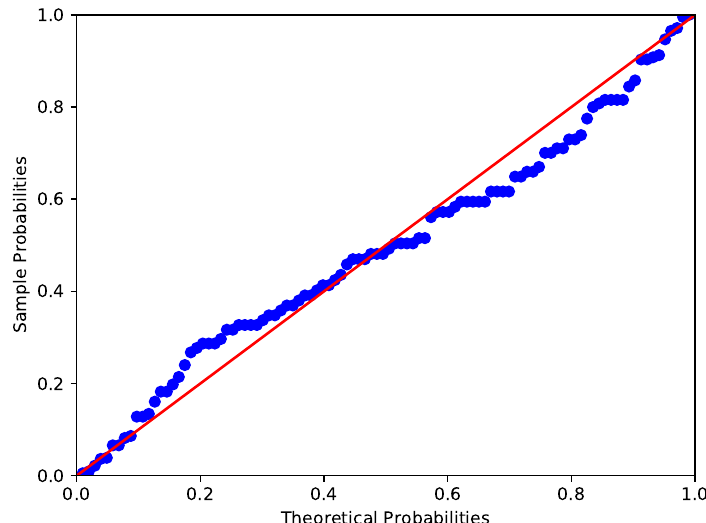
Figure 5. P-P plot of RBC count in male athletes (Red line and blue line respectively denote the theoretical probabilities and sample probabilities).